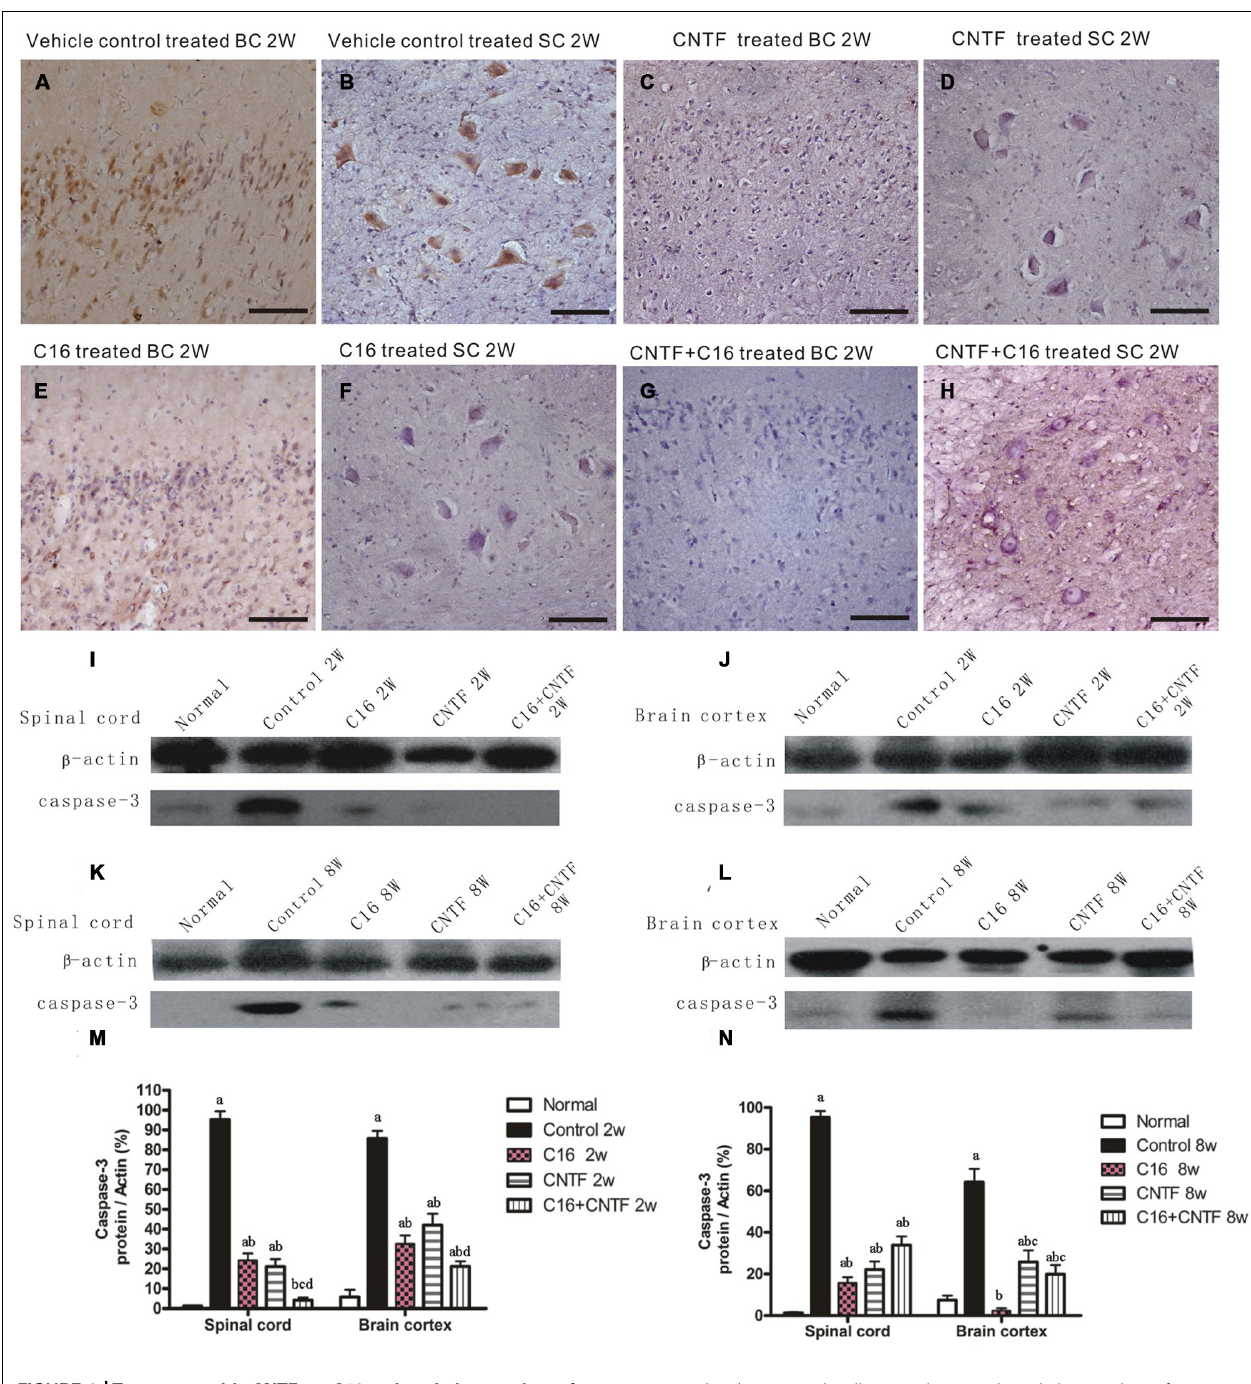
expression in neuronal cells was decreased, and the number of caspase-3 + apoptotic neural cells was also obviously reduced. Caspase-3 expression declined markedly both in the spinal cord (I,K) and cerebral cortex (J,L) following treatment with CNTF or C16 at weeks 2 and 8 post-immunization, as shown by western blotting. (M,N) Caspase-3 expression in the spinal cord and brain cortex at week 2 (M) and week 8 (N) post-immunization revealed by western blotting. a P < 0.05 versus the normal control; b P < 0.05 versus